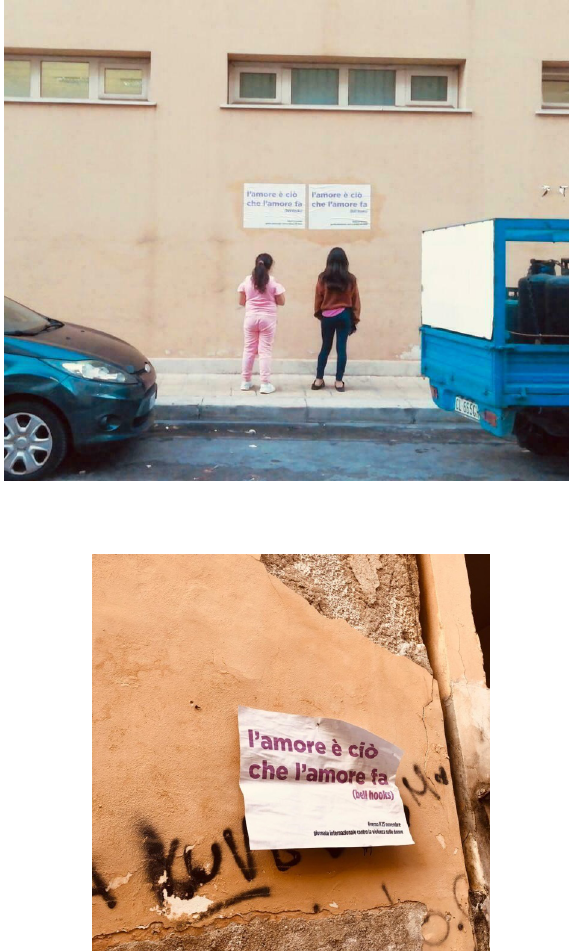
Fig. 2 : The bell hooks doll with Concetta and Mariella, two of the women who designed and made her